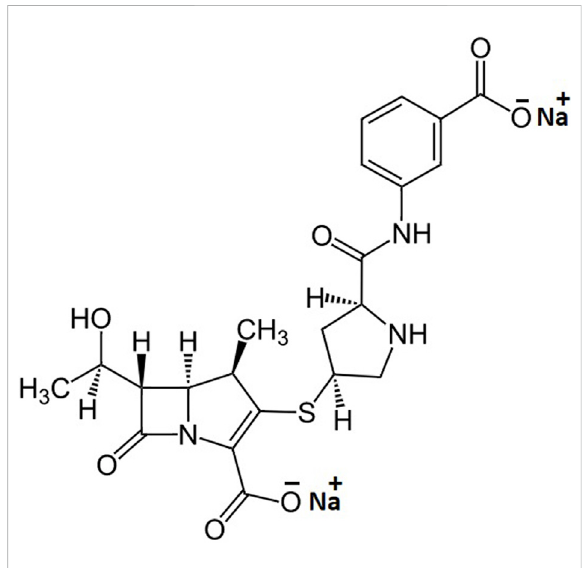
FIGURE 1 Chemical structure of sodium salt of